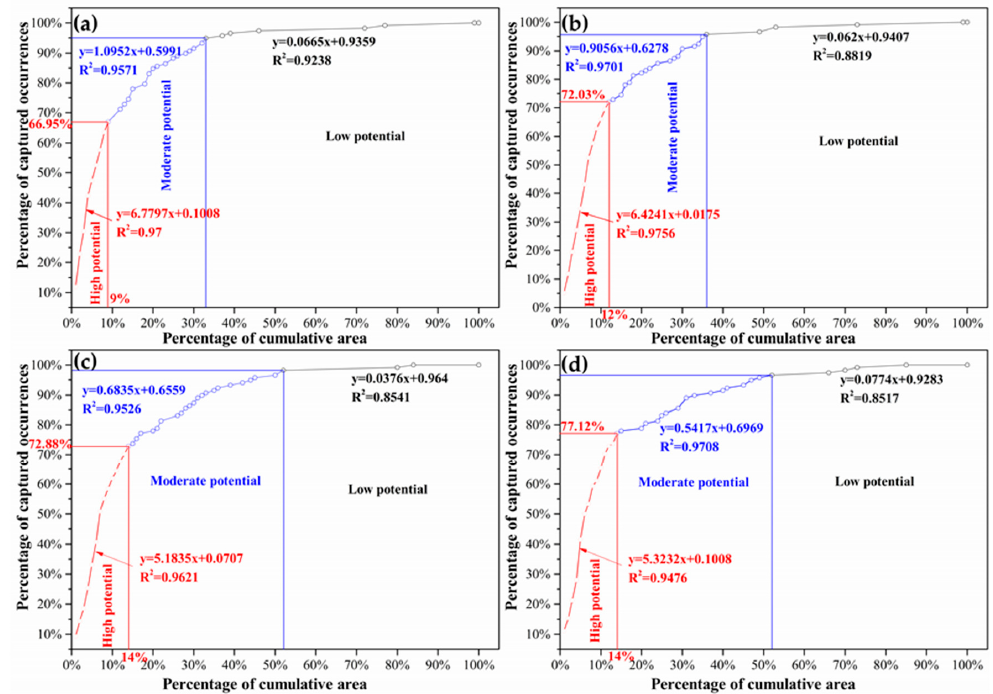
Figure 12. Success ‐ rate curves of predictive models: ( a ) RF; ( b ) SVM; ( c ) ANN; and ( d ) CNN models.